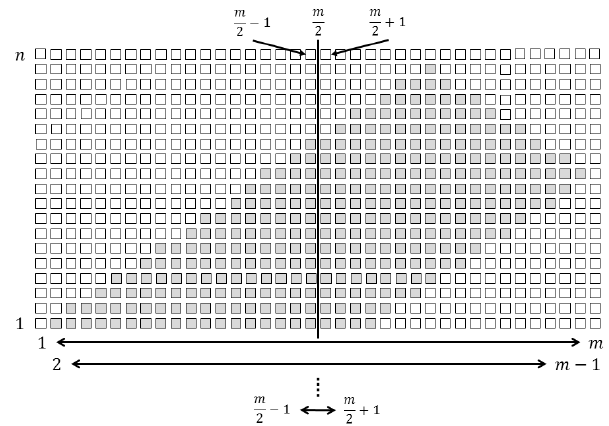
Figure A1. Schematic demonstrating the principle of cross section flipping. 2 Fig. A1. Schematic demonstrating the principle of cross section